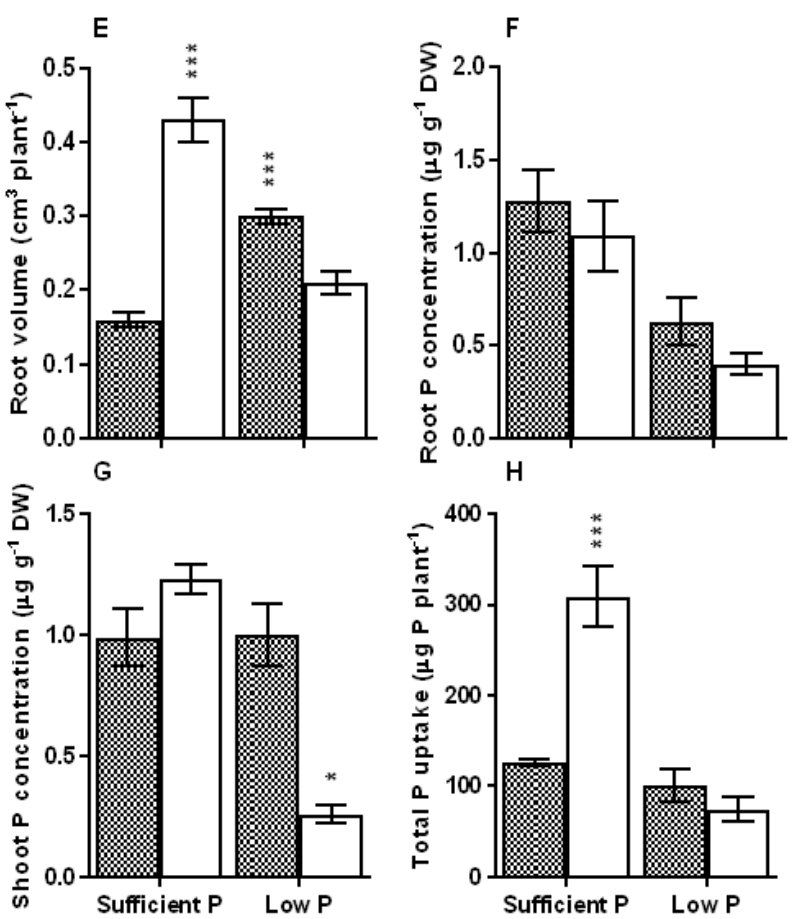
Figure 1. Variation in ( A ) total biomass, ( B ) root-to-shoot ratio, ( C ) root length, ( D ) root surface area, ( E ) root volume, ( F ) root phosphorus (P) concentration ( G ) shoot P concentration and ( H ) total P uptake in contrasting soybean genotypes grown at sufficient (250 µM) and low (4 µM) P. Data correspond to mean ± Standard Error ( n = 9). DW: dry weight. *, ** and *** denote significance at 0.05, 0.01 and 0.001 probability levels, respectively.